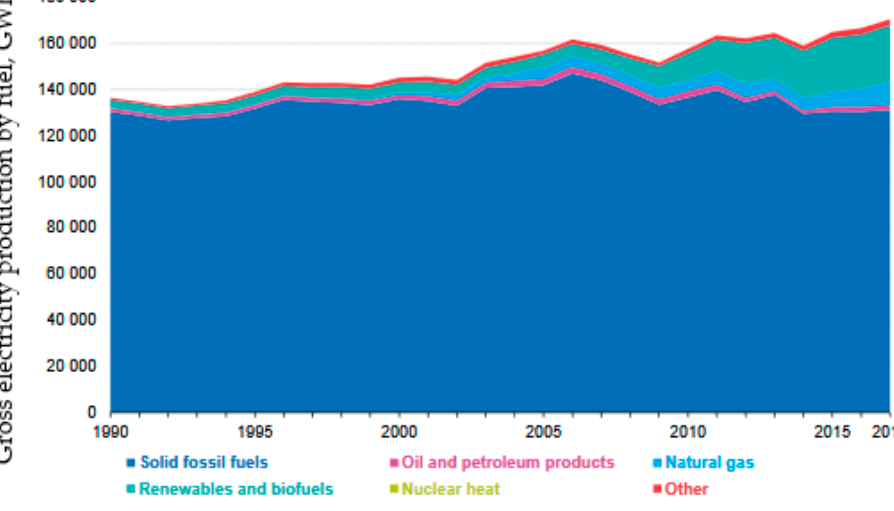
Figure 2. Gross electricity production by fuel in Poland [33].